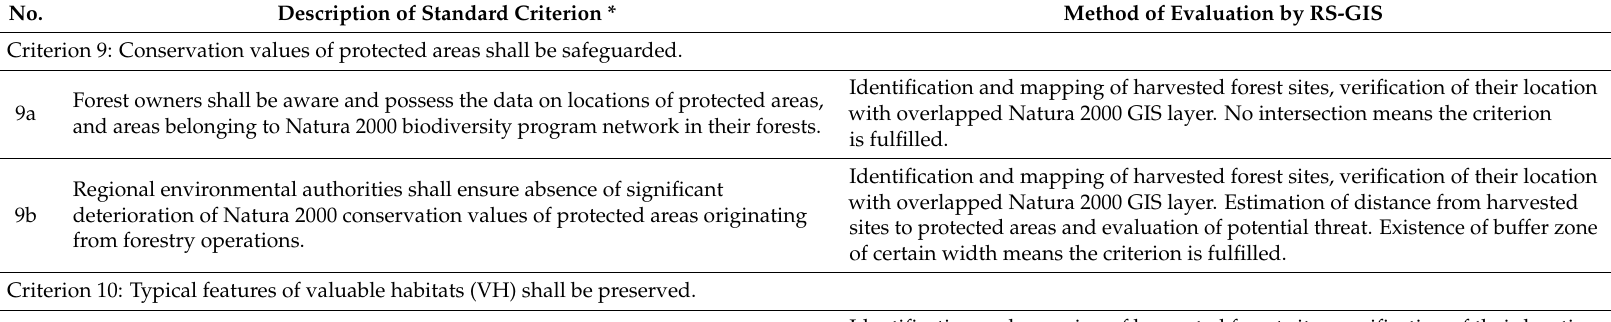
Table 2. The potential criterion of the PEFC FI 1002:2014 standard for verification with remote sensing geographical information system (RS-GIS) techniques.